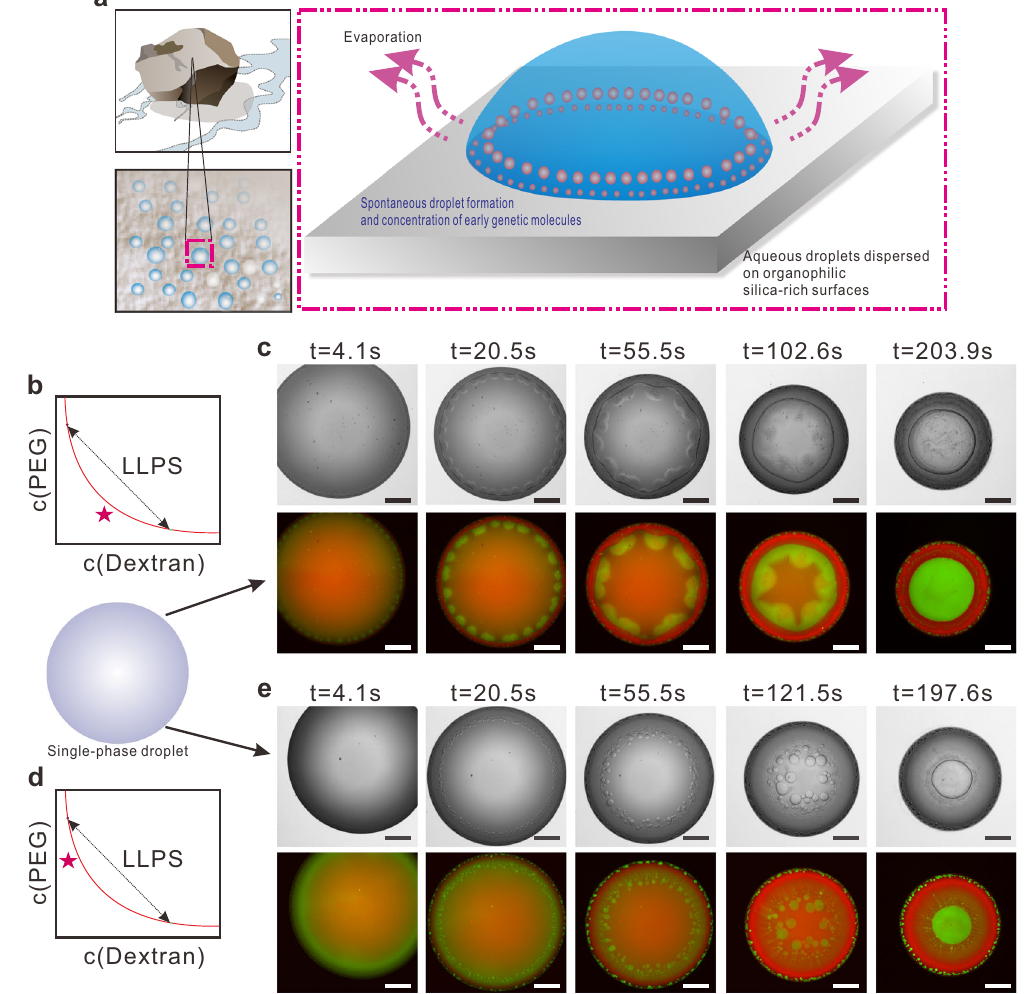
Fig. 1 Evaporation-triggered segregative LLPS inside the all-aqueous sessile droplet. a Schematic drawing of early genetic molecule compartmentalization inside the evaporating aqueous droplets. According to timeline of the early history of life, the Pre-RNA world and RNA world may have occurred at 3.8 – 4.0 Gya 77 , with the fi rst RNA polymers formed in warm little ponds 78 . Silica-rich surface could serve as the reactor that supports various prebiotic reactions such as the polymerization of the polynucleotides; 42,79 b , d Phase diagrams of PEG and dextran mixtures. The red solid line is the binodal curve that distinguishes the single-phase region and the two-phase coexistence region. The arrowed line represents the tie line of ATPS, along which a mixture undergoes liquid-liquid phase separation (LLPS) and forms a PEG-rich phase and a dextran-rich phase. The star represents the composition of the sessile droplet, with 5 wt% PEG – 10 wt% dextran in ( b ) and 9 wt% PEG – 4 wt% dextran in ( d ); c Phase-separated pattern evolution inside an evaporating droplet of regime 1, shown in both bright- fi eld image sequence and fl uorescence image sequence, respectively; The dextran-rich phase is labeled by fl uorescein isothiocyanate-dextran (FITC-dextran, green) and PEG-rich phase is labeled by Rhodamine B (red). e Phase-separated pattern evolution inside an evaporating droplet of regime 2, shown in bright- fi eld image sequence and fl uorescence image sequence, respectively; The fl uorescence labeling is the same with that in ( c ). For c and e , images are obtained over analysis of seven independent trials with relative humidity ranging from 55 to 65%. The scale bar is 500 μ green fl uorescence pro fi le inside the droplet. For a sessile droplet consisting of 5 wt% PEG and 10 wt% dextran (Regime 1, Fig. 1b), a lobe-shaped dextran-rich phase forms shortly after the evaporation begins (Fig. 1c and Supplementary Movie 1). For the droplet consisting of 9 wt% PEG and 4 wt% dextran (Regime 2, Fig. 1d), there is no such lobe-shaped area; instead hundreds of